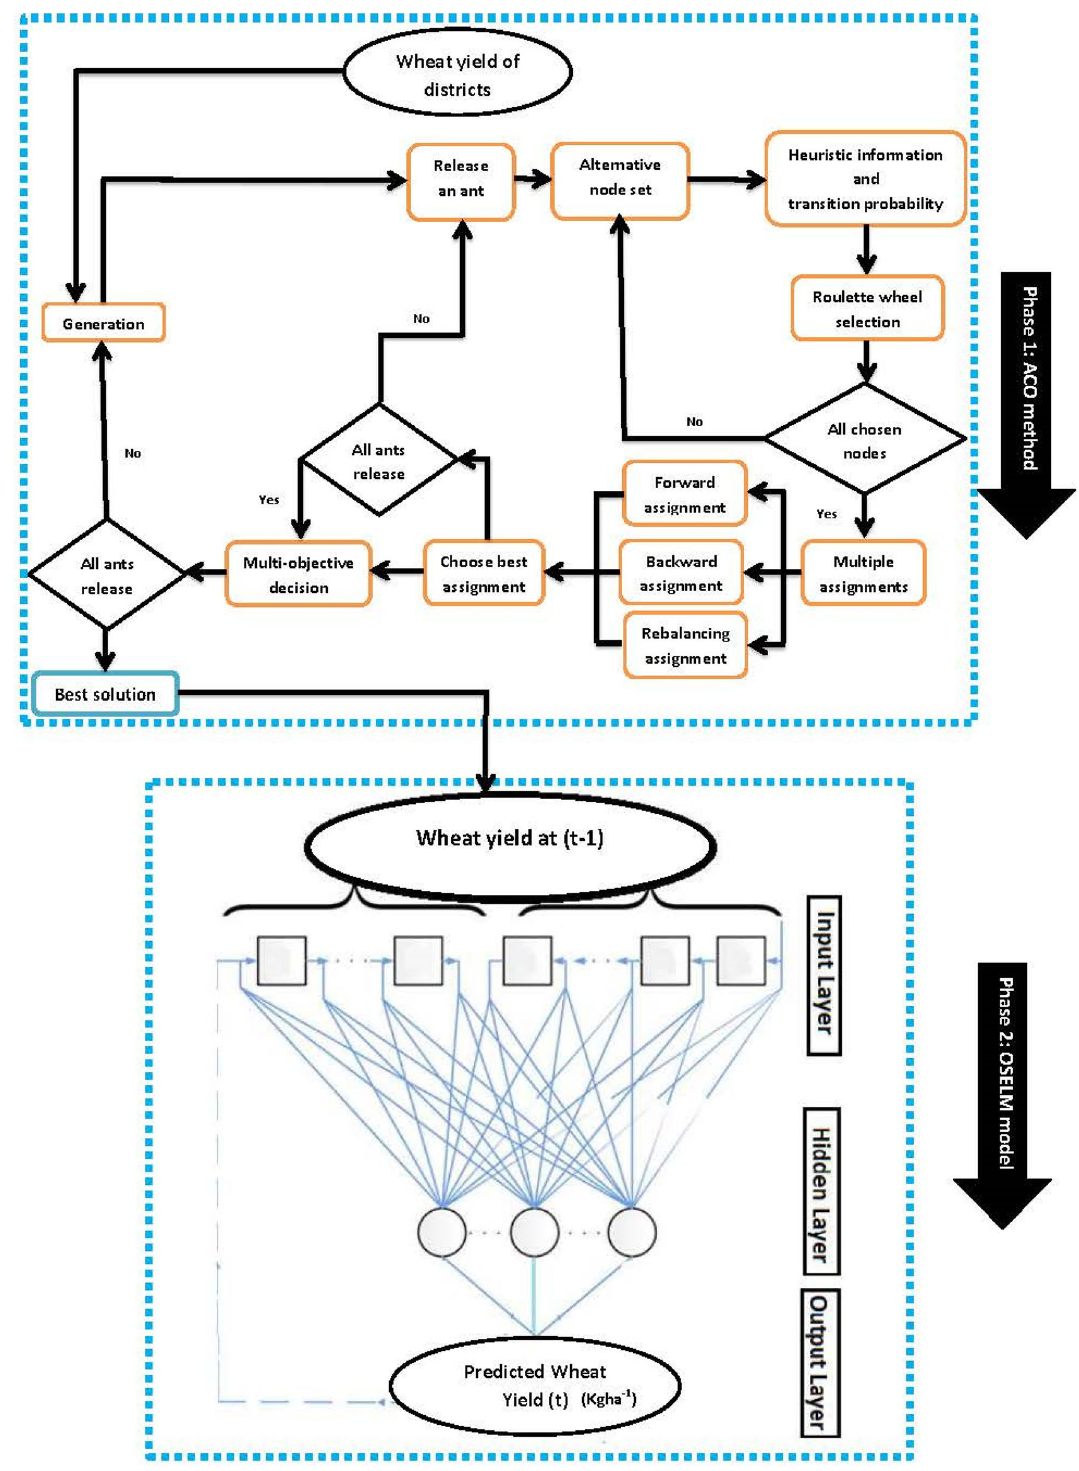
Figure 6. Flow chart of the proposed hybrid two-phase Ant Colony Optimization algorithm integrated with the Online Sequential Extreme Learning Machine (OSELM)